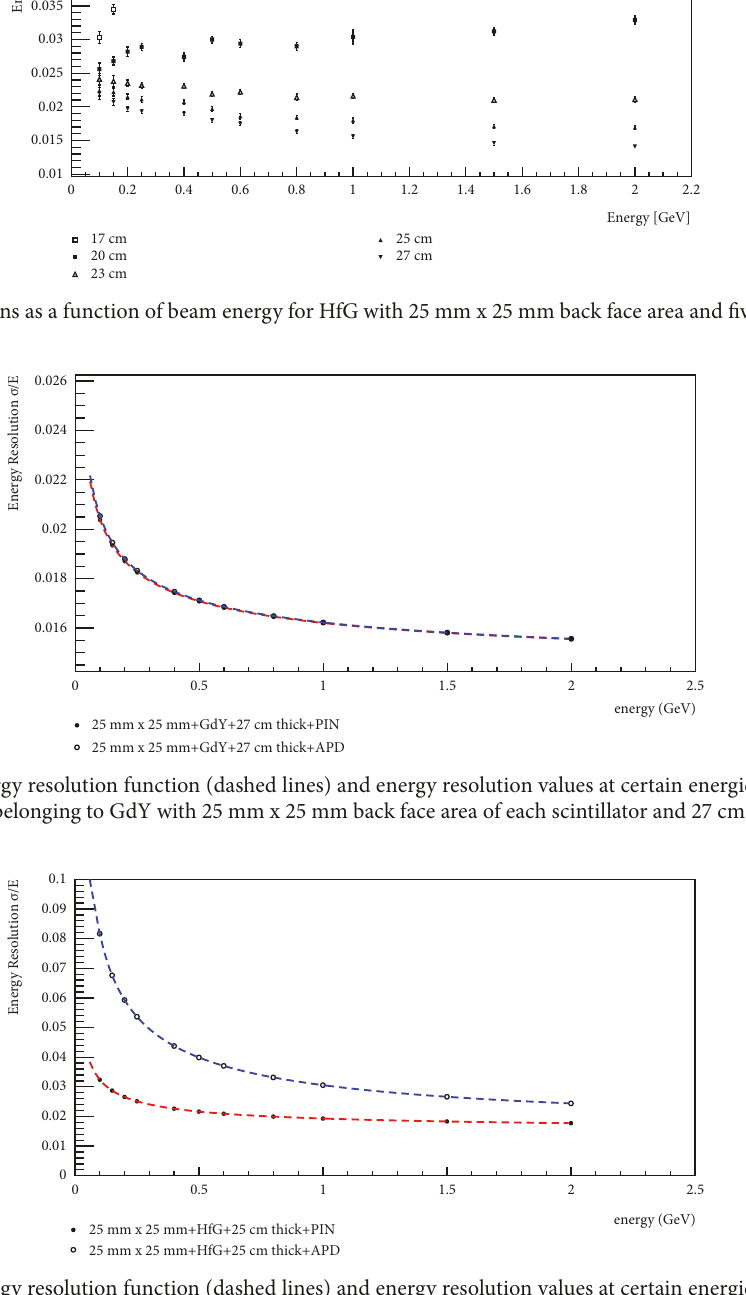
Figure 7: Parameterized energy resolution function (dashed lines) and energy resolution values at certain energies (points) for scintillator- photodetector combinations belonging to HfG with 25 mm x 25 mm back face area and 25 cm